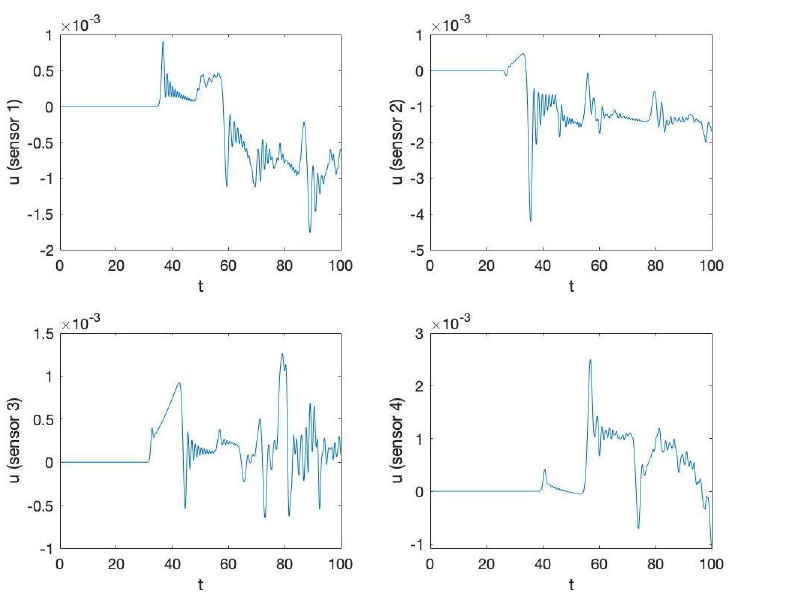
Figure 5. Values of the displacement vector u at the sensors’ location, at variance with